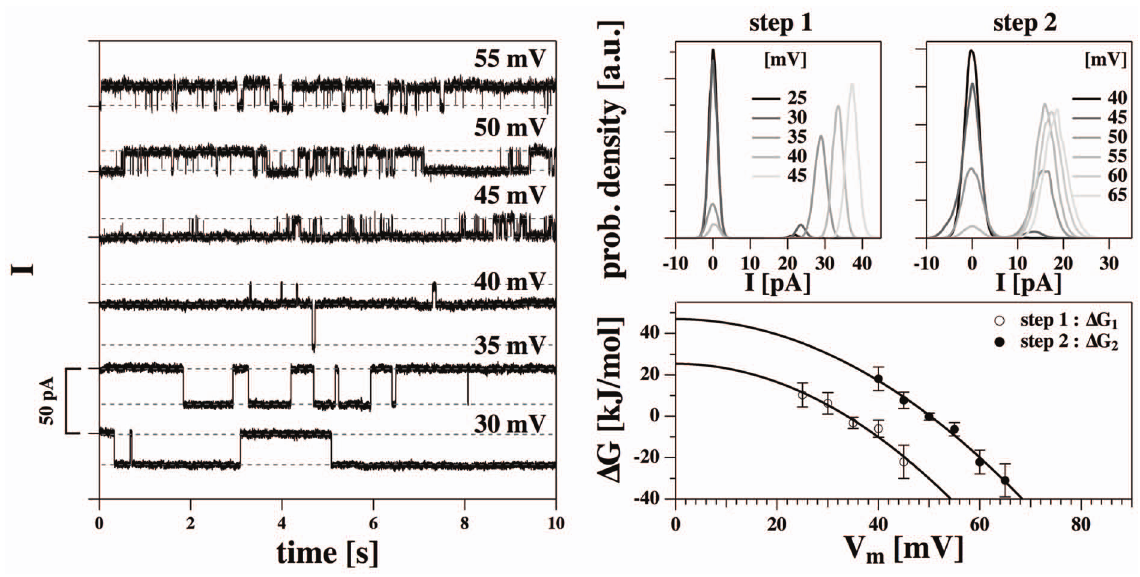
Figure 6. Recordings on a DMPC:DLPC membrane at 29 6 C. Left: Current traces at 6 voltages from 30 mV to 55 mV. THe trace at 40 mV shows twos large and a small current step. Right, top: Probability distribution for the first (left) step with a conductance of c =830 pS and the second open state (right) with a conductance of c =287 pS. Bottom: The calculated free energy difference for both conduction steps is consistent with a nearly identical quadratic voltage dependence ( D G 0,1 =25.4 kJ/mol; a 1 = 2 22.2 : 10 3 kJ/mol : V 2 ; D G 0,2 =46.9 kJ/mol; a 2 = 2 18.6 : 10 3 kJ/mol : V 2 ).